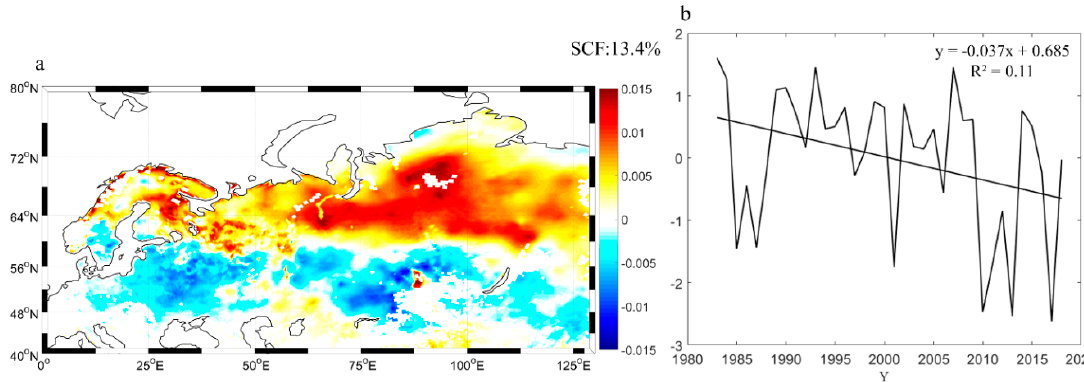
Figure 3. ( a ) Spatial characteristics of the second mode of the empirical orthogonal function in average Eurasian winter snow water equivalent from 1983 to 2018; ( b ) principal component time series of the second mode of the empirical orthogonal